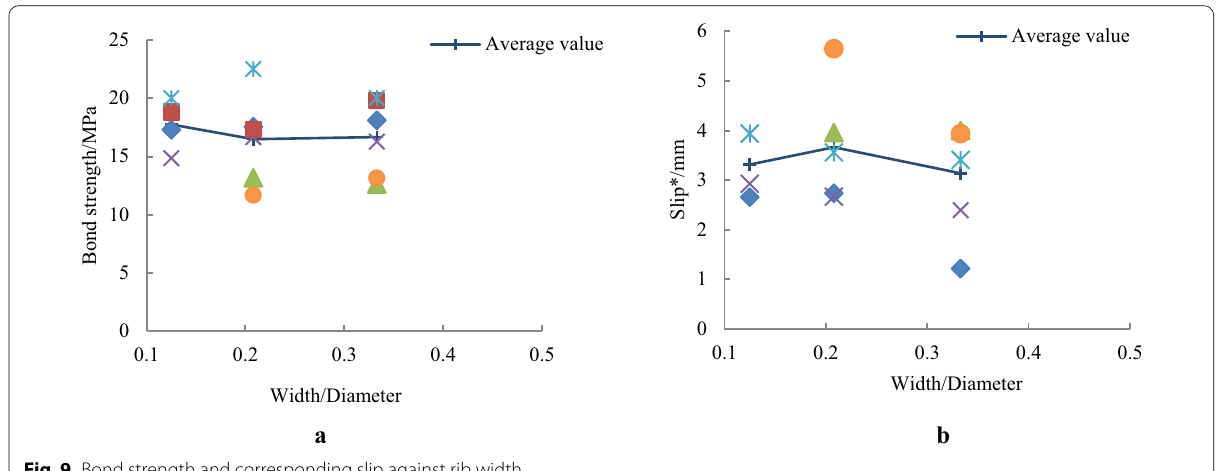
Fig. 9 Bond strength and corresponding slip against rib width.